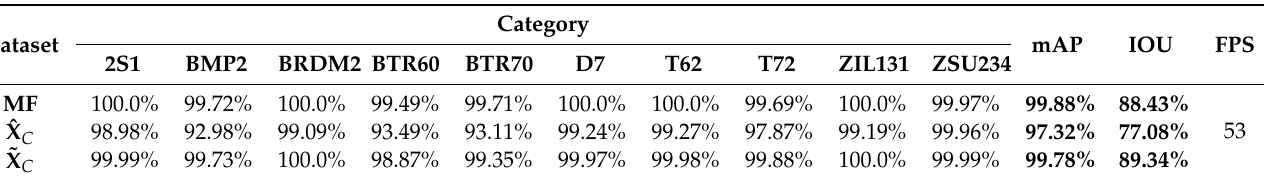
Table 3. Target detection under